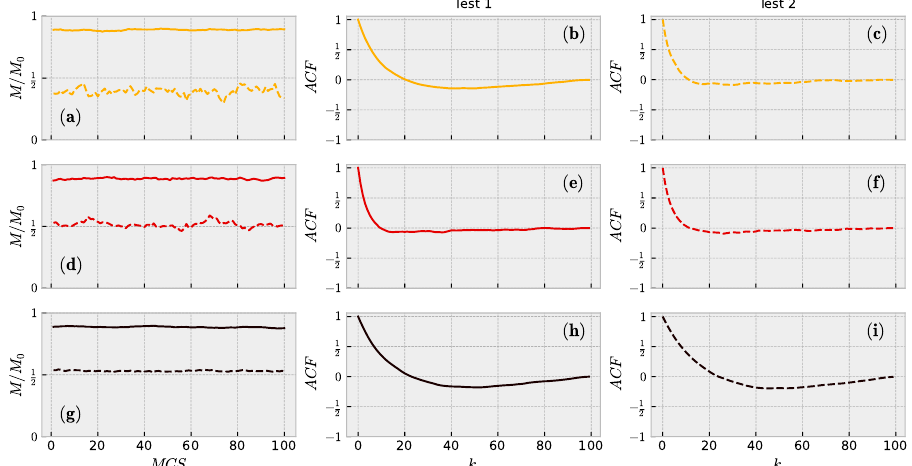
Figure A2. ( a , d , g ) single particle reduced magnetization as a function of the Monte Carlo steps for percentages of acceptance of 10% (orange), 50% (red) and 90% (black), respectively. ( b , e , h ) show the autocorrelation function for the magnetic field H ≈ H 0 and ( c , f , i ) for H < H 0